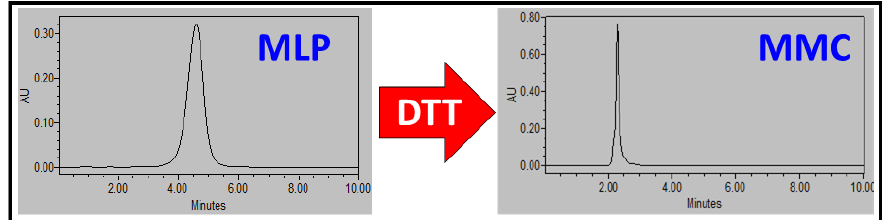
Figure 4. HPLC chromatograms showing the thiolytical conversion of MLP (prodrug, left ) to MMC (active drug, right ) after exposure to DTT 0.5 mM for 10 min at 37